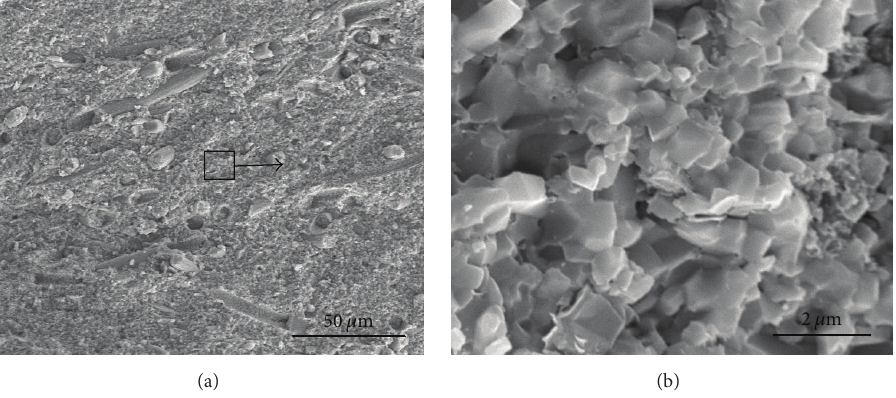
Figure 2: Hot pressed specimen of the C w /SiC